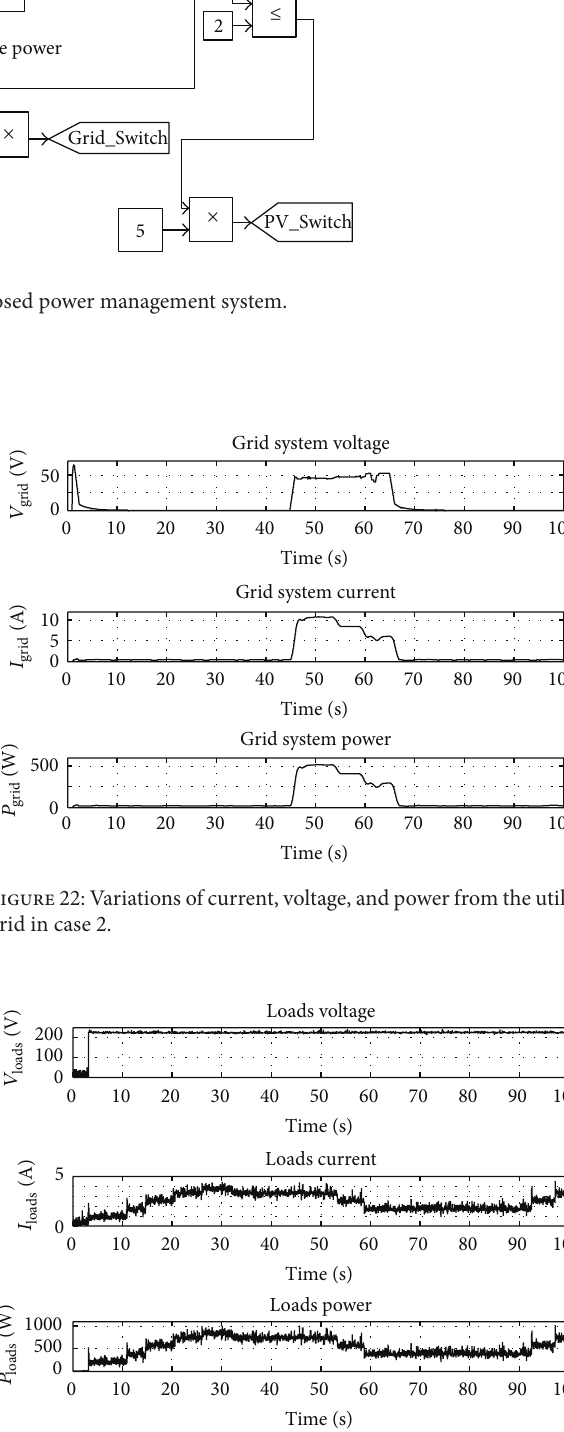
Figure 23: Current, voltage, and power change on the load in case